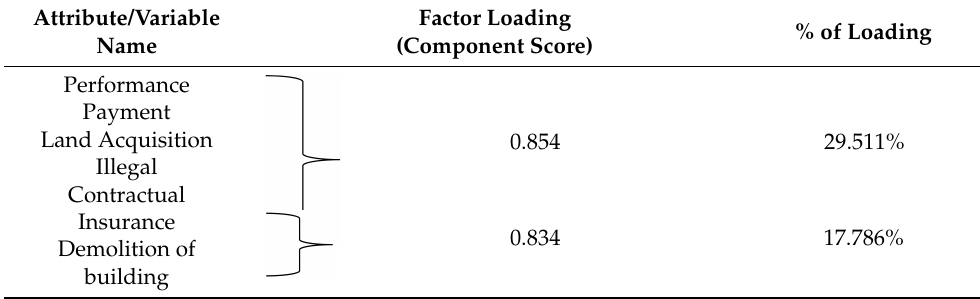
Table 10. Exploratory Factor